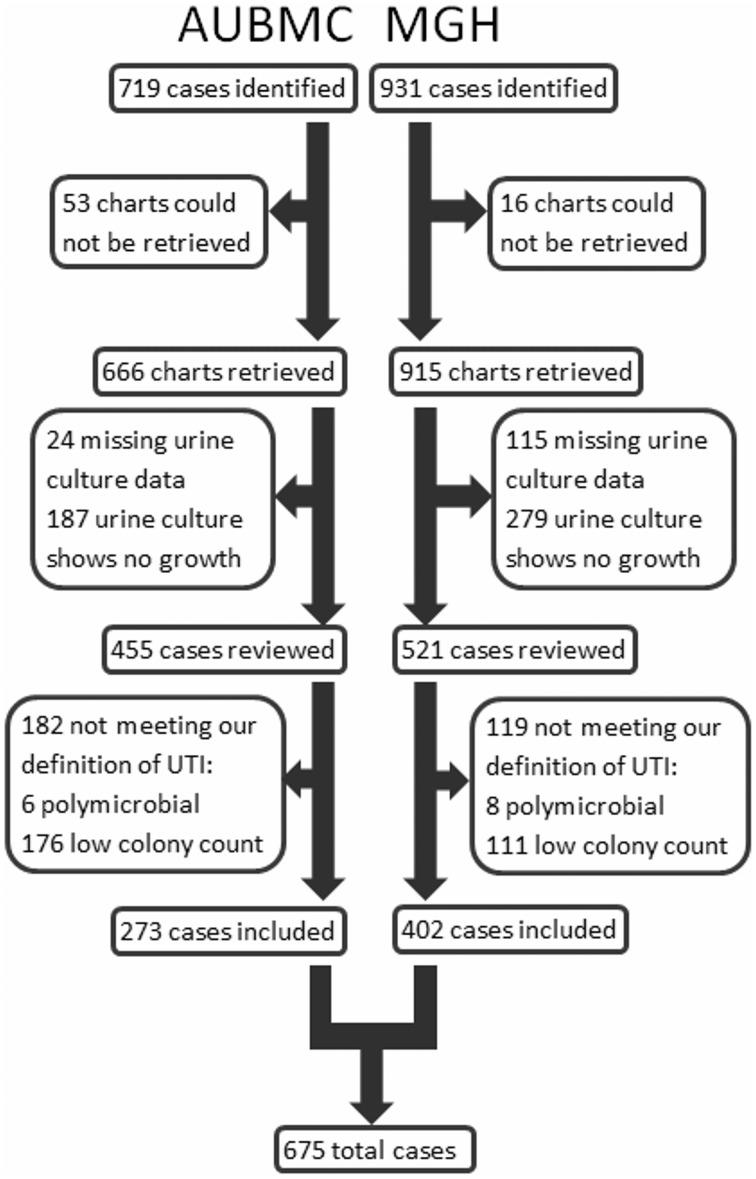
Identification and inclusion of cases into the study.